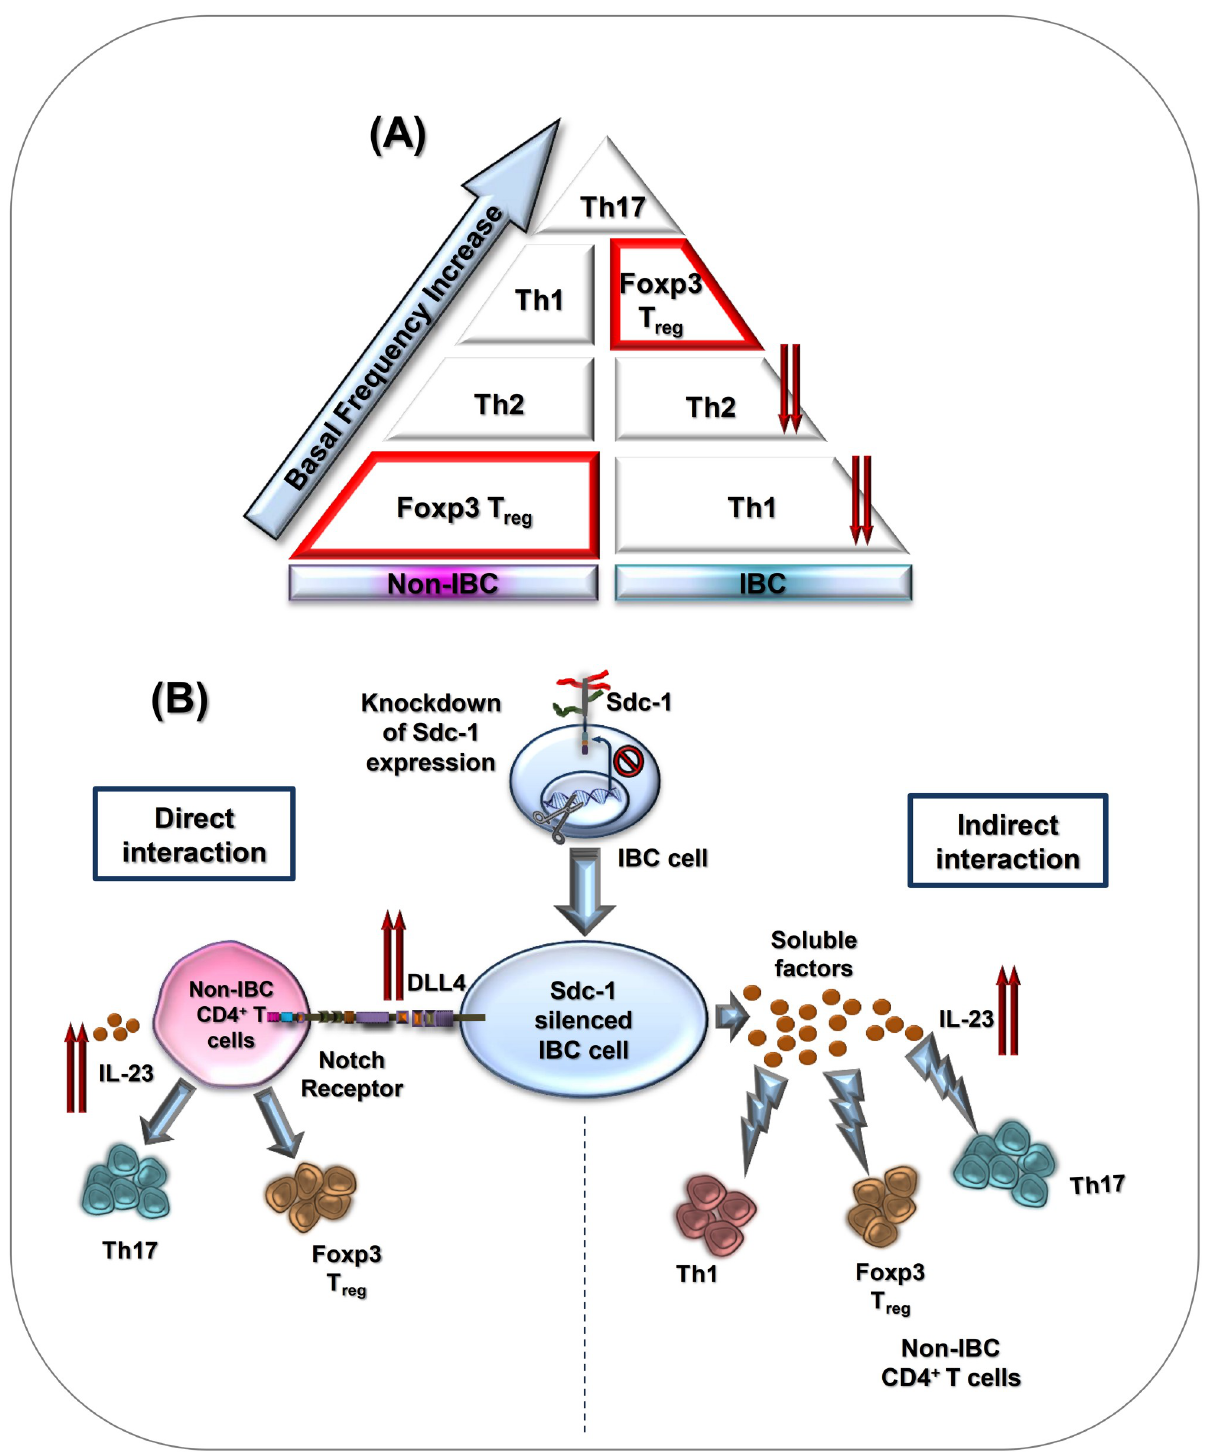
Fig 6. Schematic diagram shows the basal immunophenotyping of axillary Th cells of non-IBC vs. IBC patients, and the immunoregulatory role of tumor Sdc-1 for CD4 + Th cell polarization of non-IBC patients. (A) IBC patients are characterized by lower frequencies of circulating Th 1 and Th 2 subsets drained from axillary tributaries as compared to non-IBC patients. Relative to other Th subsets, T reg (CD4 + Foxp3 + ) subset represents the lowest frequency among Th cells of non-IBC patients. (B) Upregulation of IL-23 and DLL4 expression mediated by Sdc-1 silencing in IBC cells may drive Th 17 polarization under indirect and direct co-culture conditions. In addition, Sdc-1 silencing enhances T reg cell polarization under both indirect and direct co-culture conditions, whereas induces only Th 1 polarization under indirect co-culture conditions.